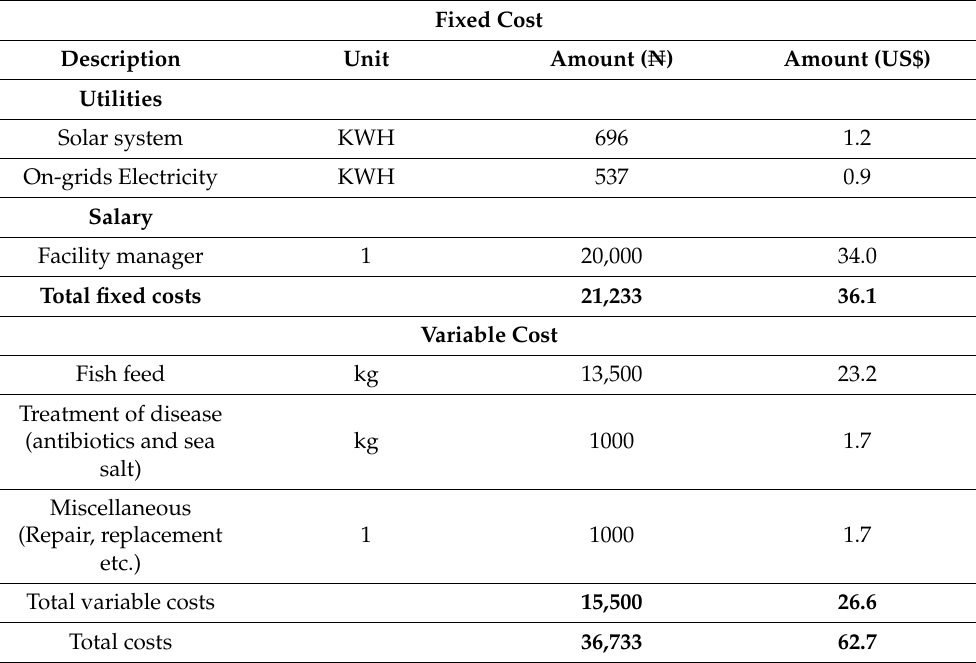
Table 1. Overview of monthly fixed and variable cost of simplified RAS in Lagos,